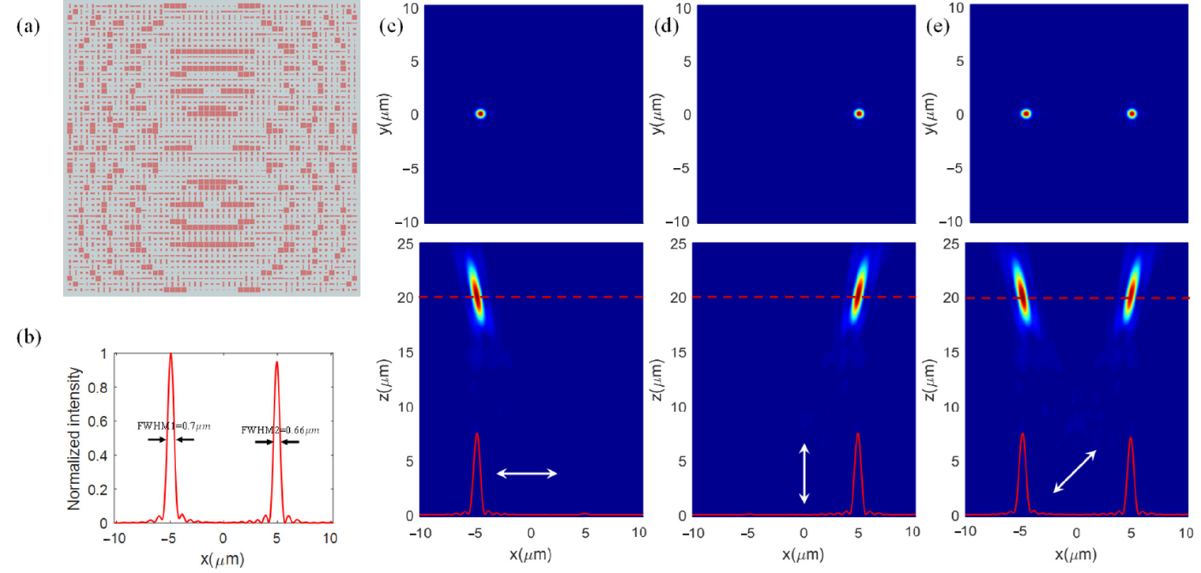
Figure 3. ( a ) Transmittance and ( b ) phase delay for x-linearly polarized light incidence with different lengths L and widths W.